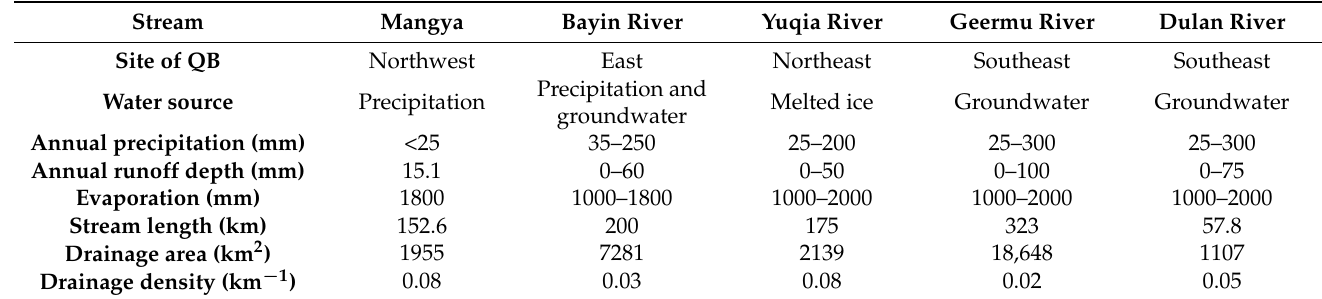
Table 1. The hydrological characteristics of streams in the Qaidam Basin. Organized by Tan Yi and Zhang Jiazhen [20]. QB: Qaidam